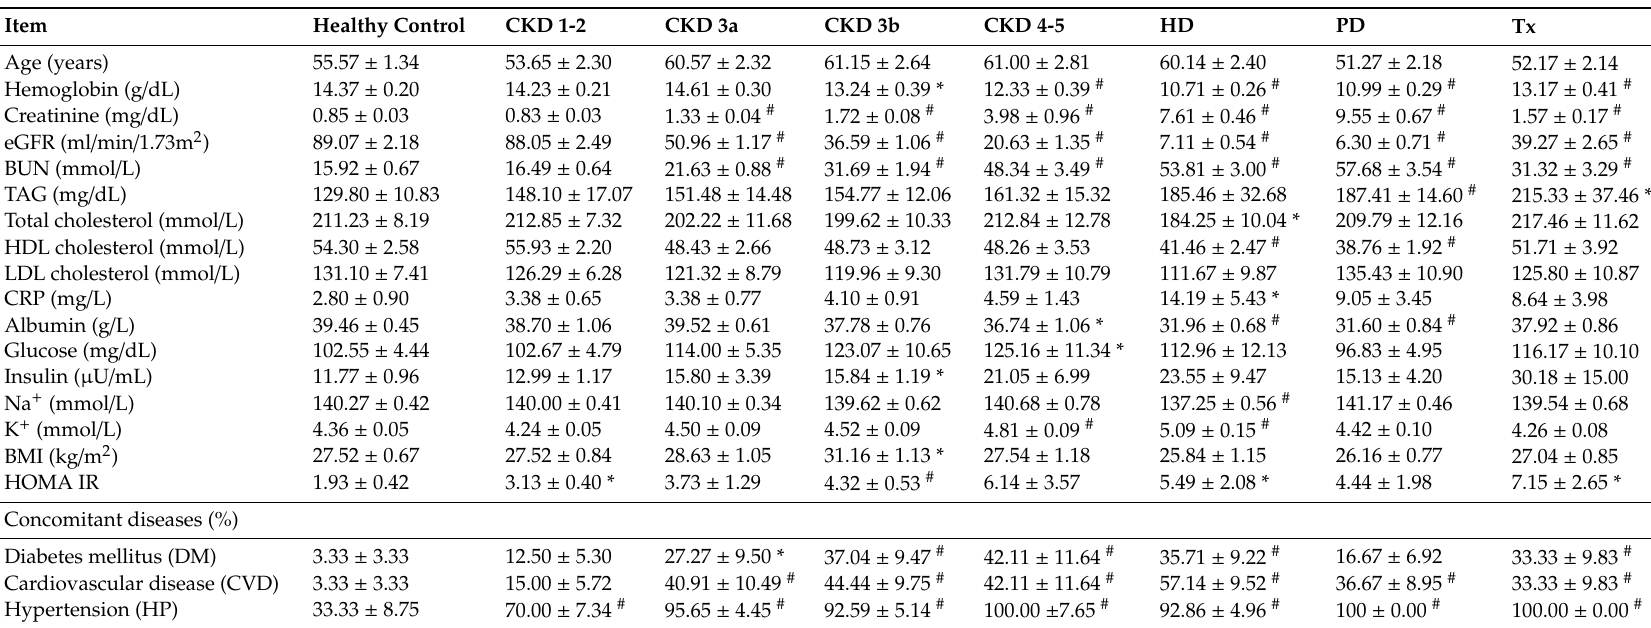
Table 1. Selected biochemical and anthropometric characteristics of the study subjects. * statistically significant comparing to controls at p < 0.05; # p <